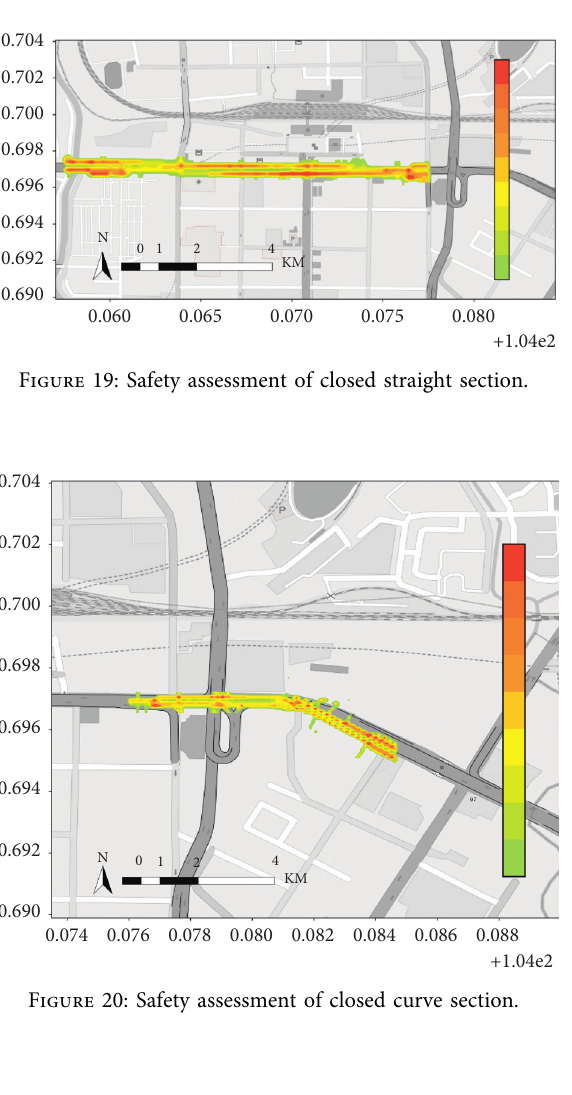
Figure 18: Daily variation of vehicle conflict risk in vehicle exit section.